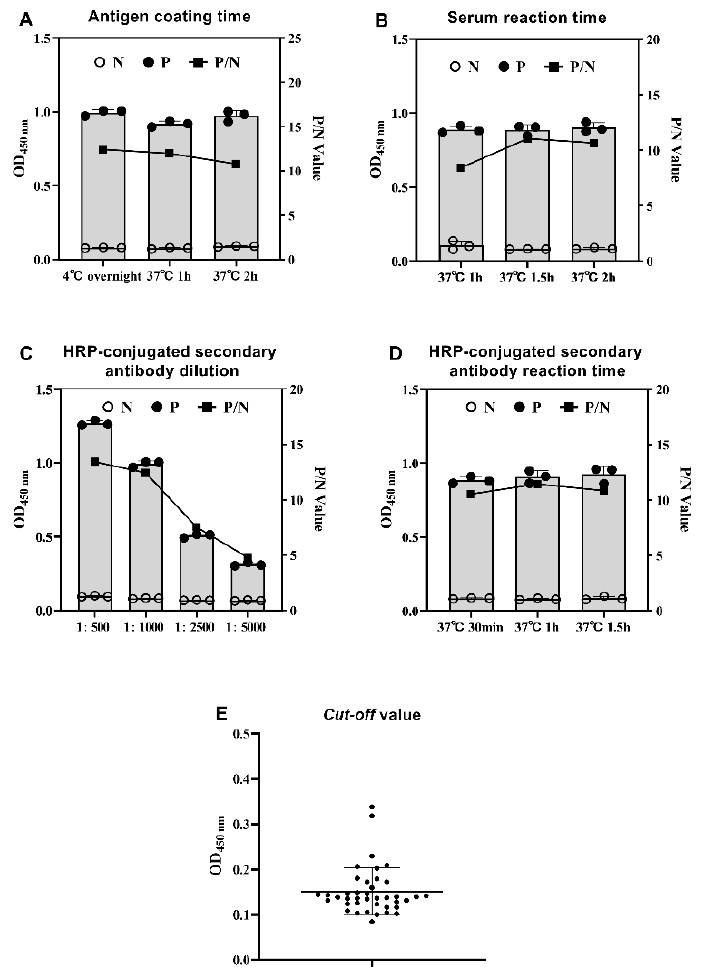
Figure 4. Optimization of GAstV-2-Cap-ELISA reaction conditions. ( A ) Optimization of protein coating conditions. ELISA plates with 125 ng/well coating protein were incubated at 4 ◦ C overnight, 37 ◦ C for 1 h, and 37 ◦ C for 2 h. ( B ) Optimization of reaction time of sera. The sera with dilutions of 1:200 were reacted at 37 ◦ C for 1 h, 1.5 h, and 2 h. ( C ) Optimization of dilution of HRP-conjugated secondary antibody. The dilution of the HRP-conjugated secondary antibody was 1:500, 1:1000, 1:2500, and 1:5000. ( D ) Optimization of reaction time of HRP-conjugated secondary antibody. The HRP-conjugated secondary antibody was reacted at 37 ◦ C for 30 min, 1 h, and 1.5 h. ( E ) The determination of GAstV-2-Cap-ELISA cut-off value. Forty negative sera were used to calculate the cut-off value of GAstV-2-Cap-ELISA.